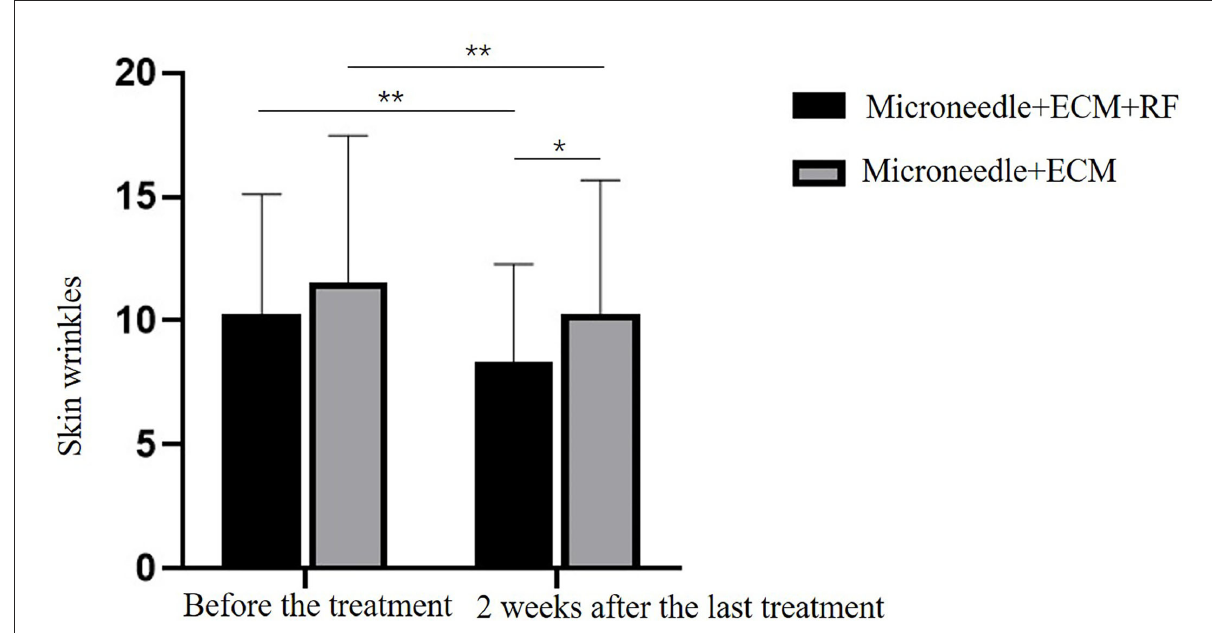
FIGURE2 Comparison graphs of periorbital wrinkles measured by VISIA. * p < 0.05, ** p < 0.01.